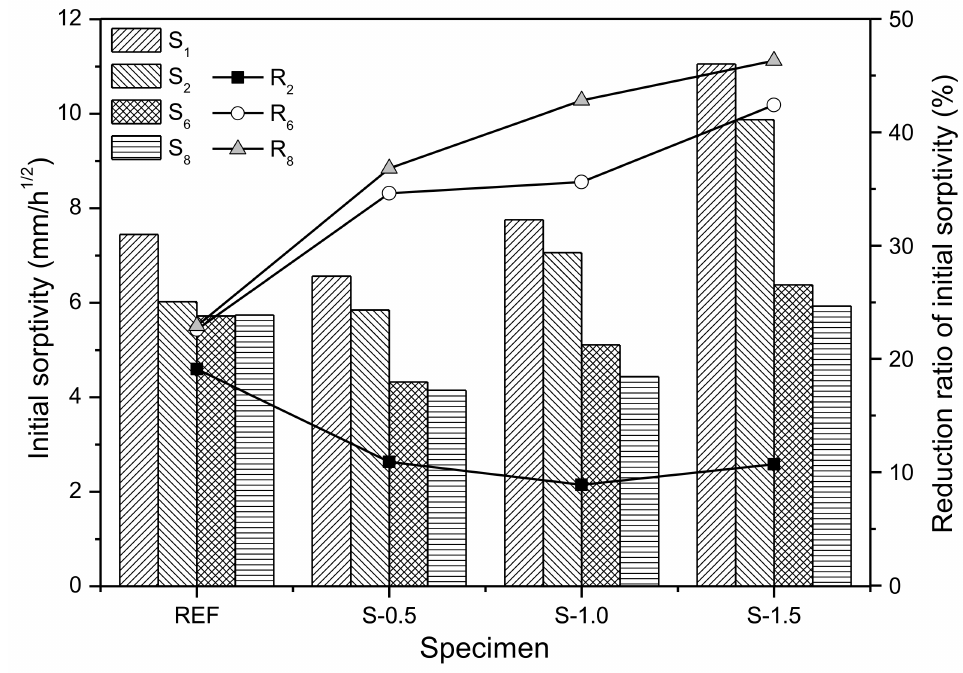
Figure 6. Initial sorptivity and reduction ratios of specimens exposed to wet/dry